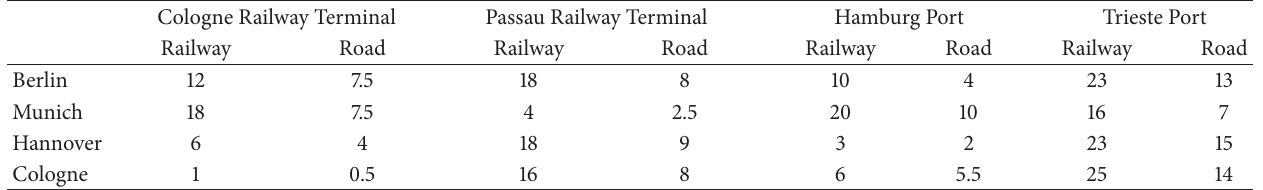
Table 4: Transportation times between the manufacturing facilities and the first level transshipment terminals